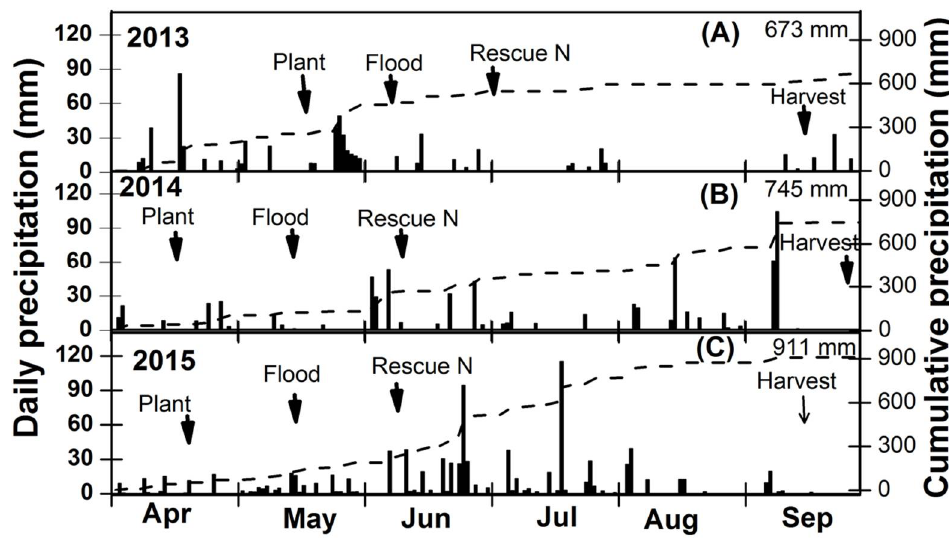
Figure 1. Daily (bars) and cumulative (line) precipitation during the 2013 ( A ), 2014 ( B ) and 2015 ( C ) growing seasons at the Greenley Research Center near Novelty, Missouri. Timings of major field events are indicated by arrows.